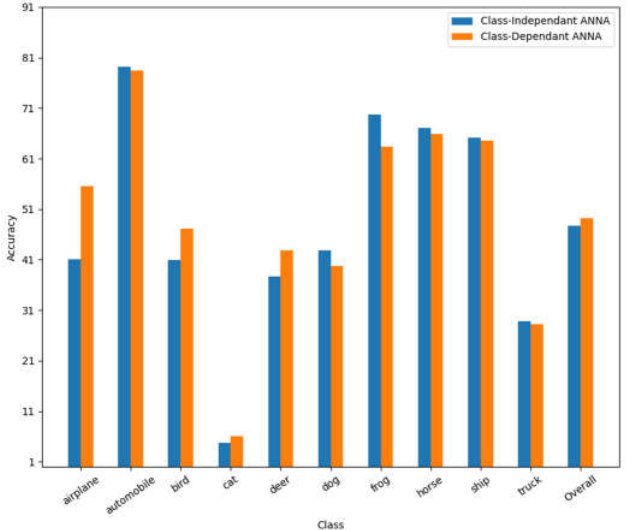
Figure 13. Overall accuracy and per-class accuracies obtained using the proposed ANNA approaches when using CIFAR-10 dataset.